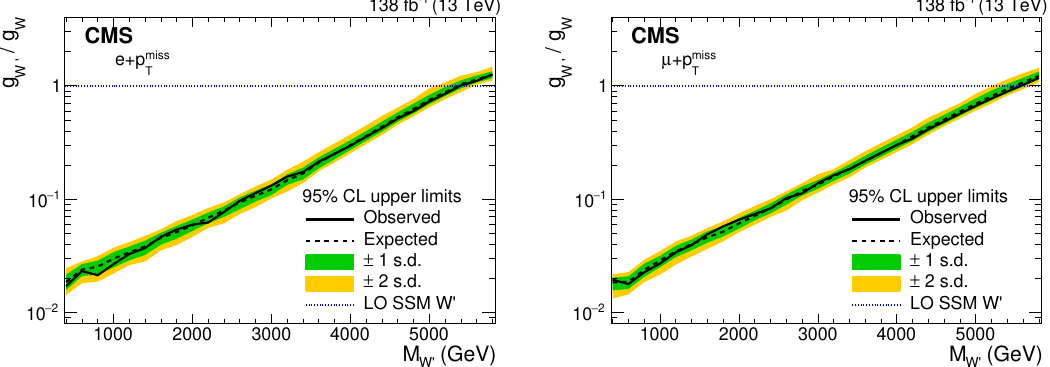
Figure 7 . The observed (solid line) and expected (dashed line) upper limits at 95% CL on the coupling strength ratio, g as functions of the mass of the W 0 boson. These are shown for the /g W W 0 electron (left) and muon (right) channels. The one and two standard deviation uncertainty bands for the expected limits are shown. The area above the limit curve is excluded. The dotted line represents the case of SSM couplings, g , being equal to g , the SM W W 0